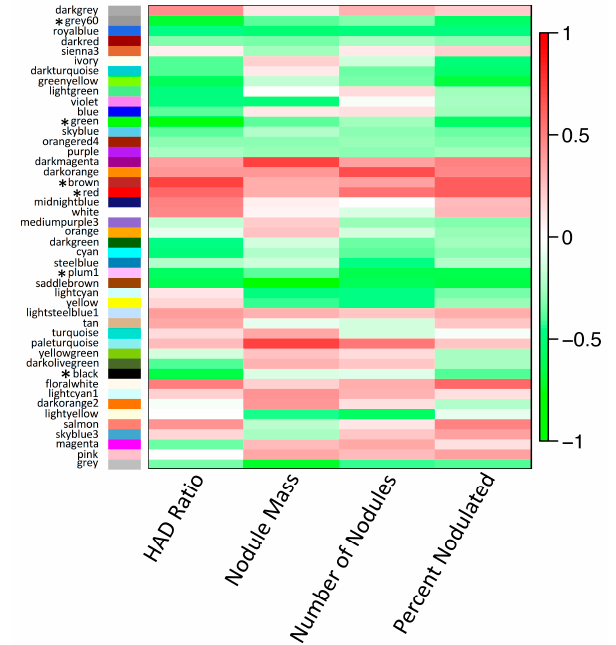
Figure 6. Correlation heatmap of eigengenes for all weighted gene co-expression network analysis (WGCNA) modules with nodulation-related trait data from [26]. Traits include the root hair deformation ratio (HAD Ratio), total nodule mass per plant (Nodule Mass), total number of nodules per plant (Number of Nodules), and percentage of plants nodulated per accession (Percent Nodulated). The heatmap is color-coded according to the Pearson correlation coefficient legend. Modules for which eigengenes are significantly correlated with HAD Ratio ( p < 0.01) are indicated with asterisks. Modules can be characterized and expression can be compared between species using module eigengene expression. In the module eigengene comparison between species for the six modules of interest identified by correlation with root hair deformation, there was significant differentiation in expression between species (i.e., “species” was a significant factor) for the ‘brown’ ( F 2, 6 = 5.957, p = 0.0376), ‘green’ ( F 2, 6 = 13.51, p = 0.006), ‘grey60’ ( F 2, 6 = 15.22, p = 0.00447) and ‘plum1’ ( F 2, 6 = 12.83, p = 0.00681) modules. In the case of the ‘brown’ module, whose eigengene expression was positively correlated with root hair deformation, D4 eigengene expression was higher than D3, with T2 expression at the higher level of D4 (Figure 7). With the ‘green’ and ‘grey60’ modules, the pattern was similar to the ‘brown’ module except that these modules were negatively correlated to the trait and D4 and T2 both expressed the eigengene at lower levels than D3 (Figure 7). For the ‘plum1’